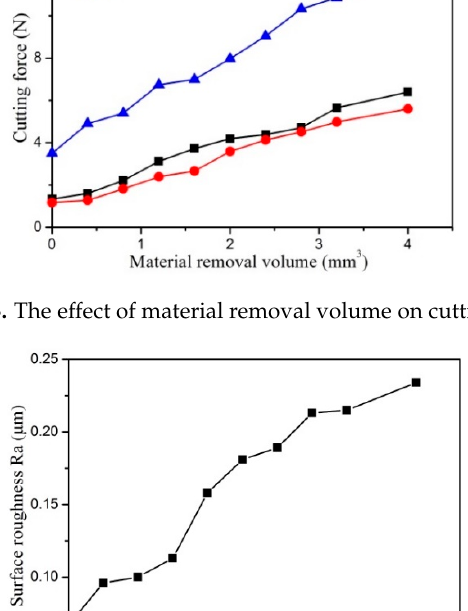
Figure 13. The effect of material removal volume on cutting force.